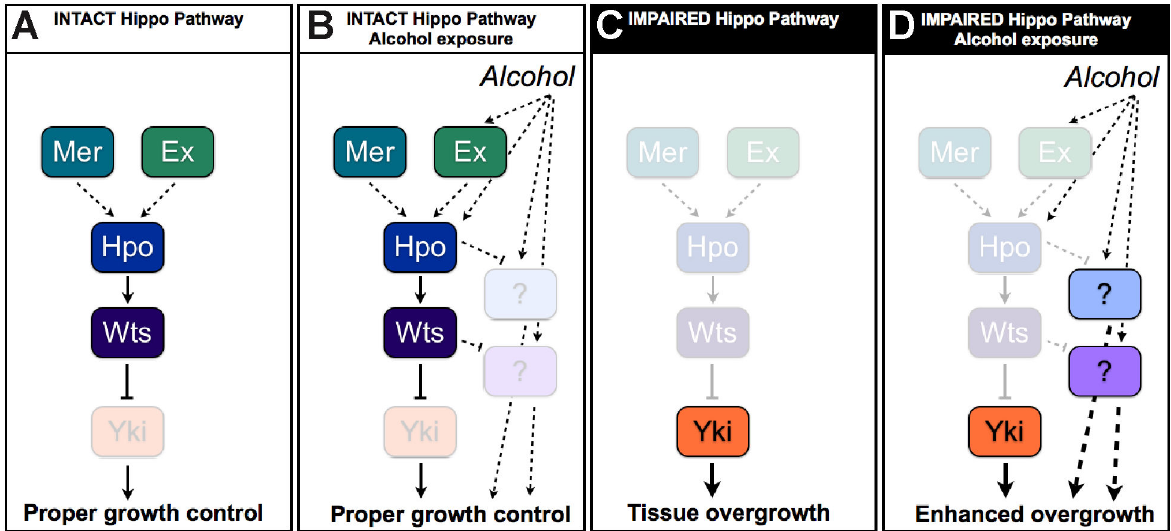
Figure 4. Model for alcohol interaction with the Hippo Pathway. As established, when Hippo signaling is intact (A), Yki is properly regulated and tissues maintain proper growth control. We propose that alcohol promotes activation of the pathway at or upstream of Hippo to target alcohol-relevant growth-promoting activities (B) to maintain proper growth control upon alcohol exposure. When Hippo signaling is impaired (C), Yki becomes overactive and promotes tissue overgrowth. We propose that when Hippo signaling is impaired in the presence of alcohol (D), Yki acts to promote overgrowth as established, and additional alcohol- relevant targets of the pathway act to promote further